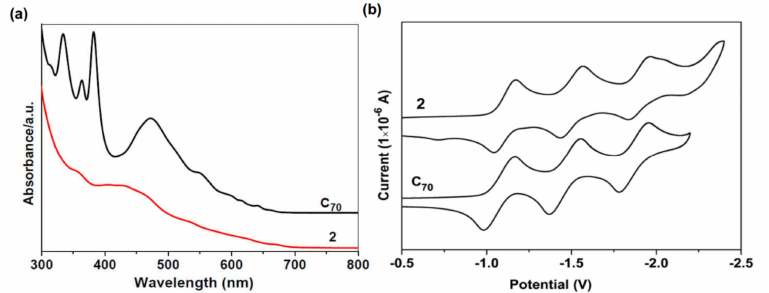
Figure 3. ( a ) UV-vis spectra of C 70 and 2 in chlorobenzene; ( b ) cyclic voltammograms of C 70 and 2 were measured in o -dichlorobenzene at room temperature under nitrogen